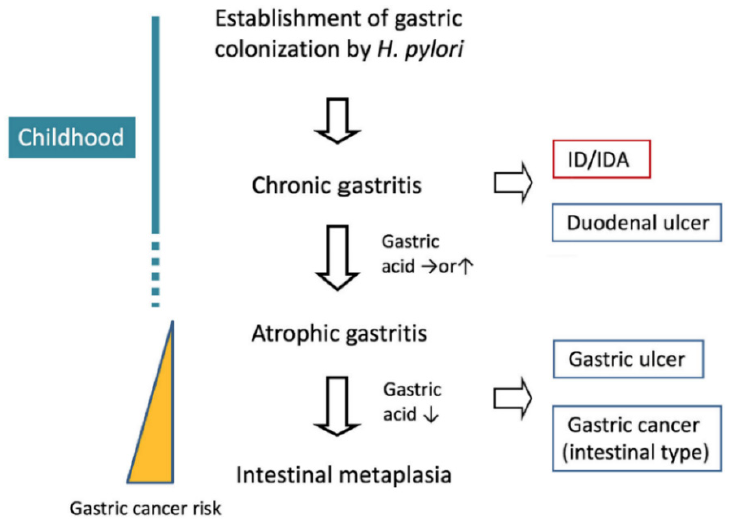
Figure 1. H. pylori infection and the related diseases.